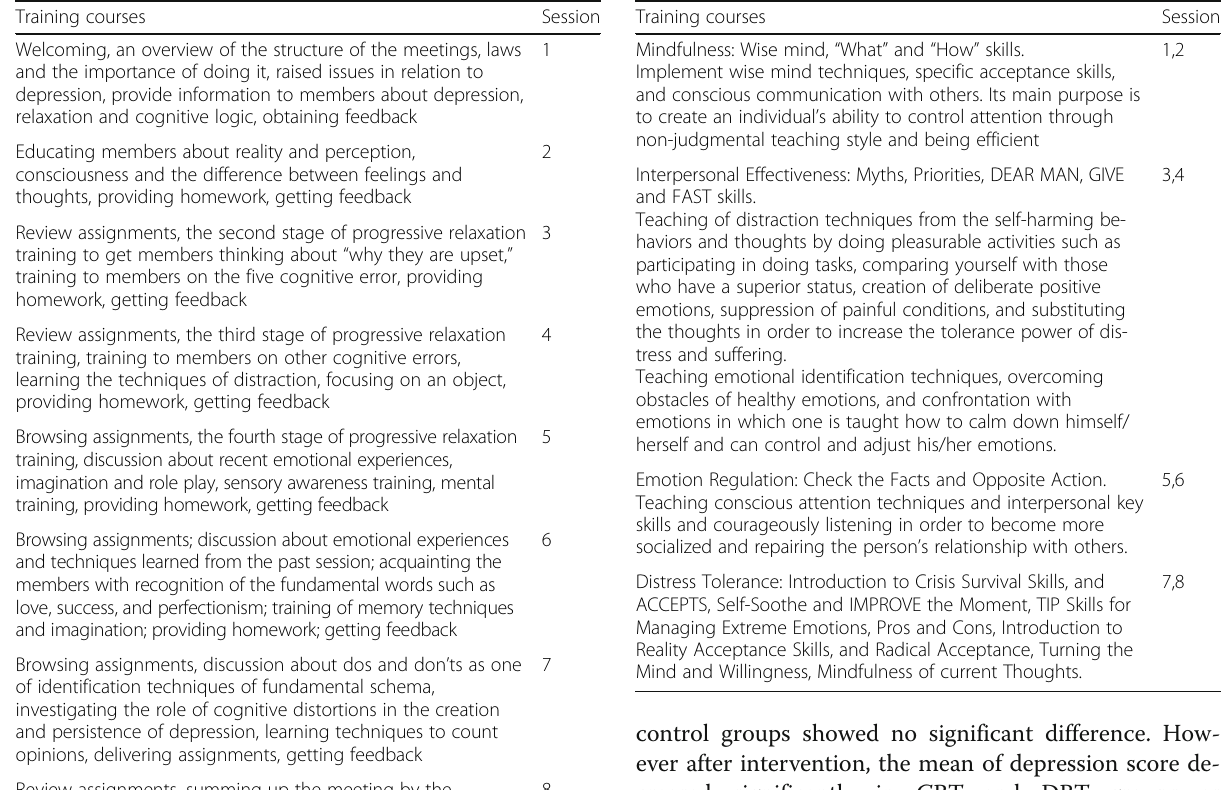
Table 1 The content of CBT training courses Training courses